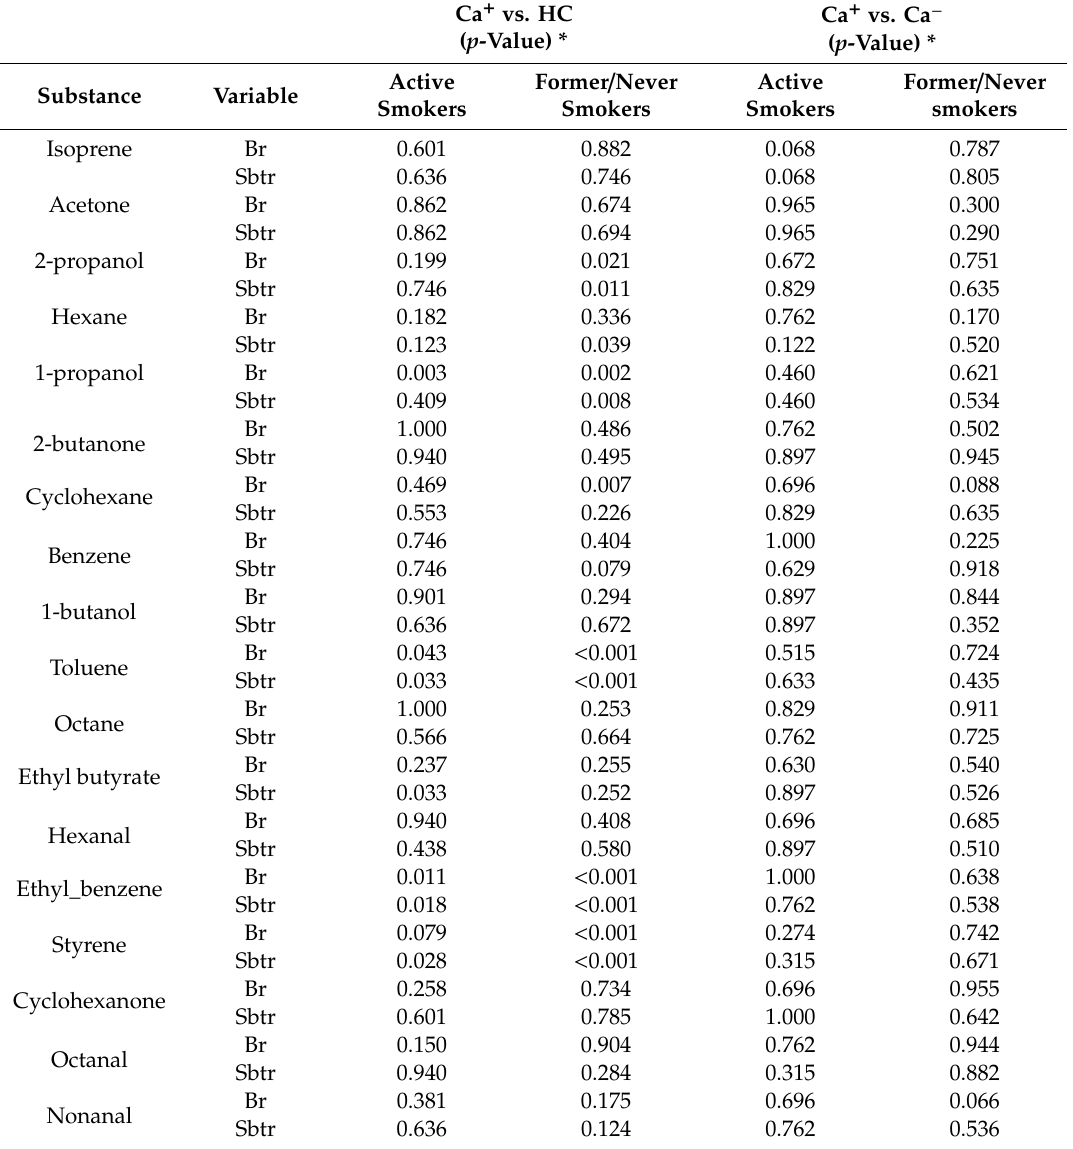
Table 4. Comparative analysis to determine associations between VOC breath concentrations and disease status, stratified by smoking